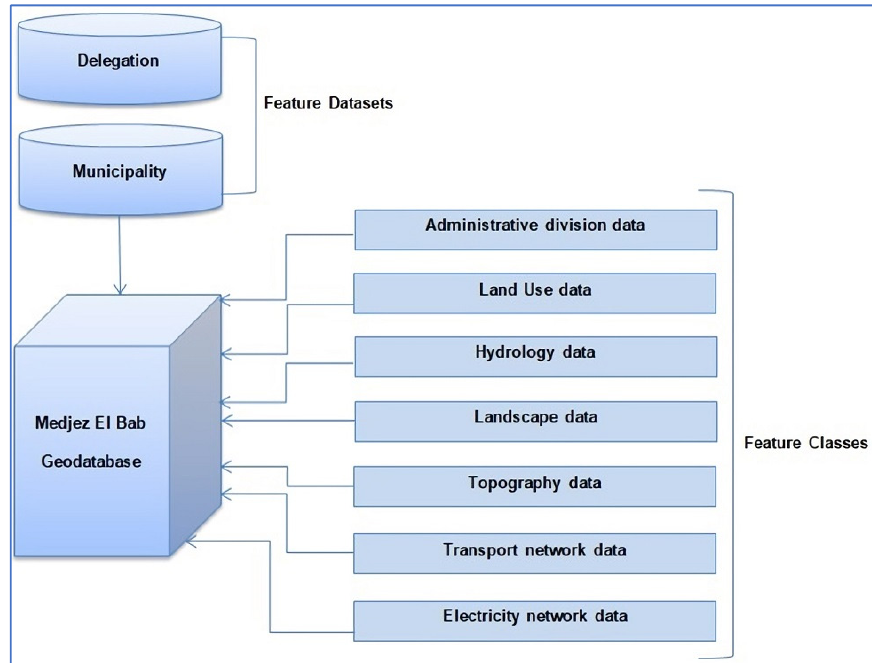
Figure 3. Geodatabase architecture and structural details.